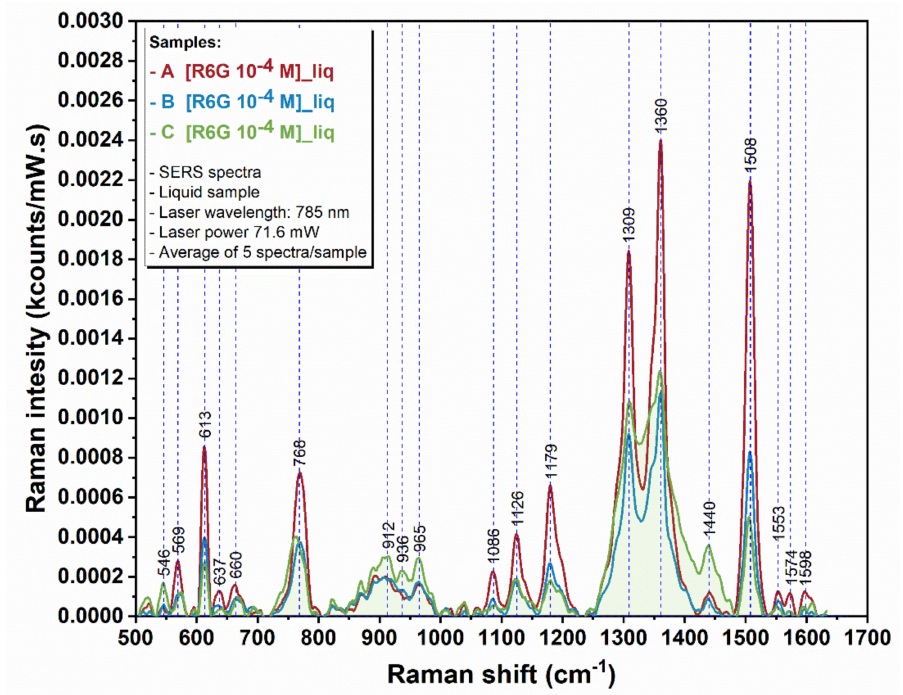
Figure 7. SERS spectra of R6G in colloidal dispersion of GNBs (samples A and B) and GNRs (sample